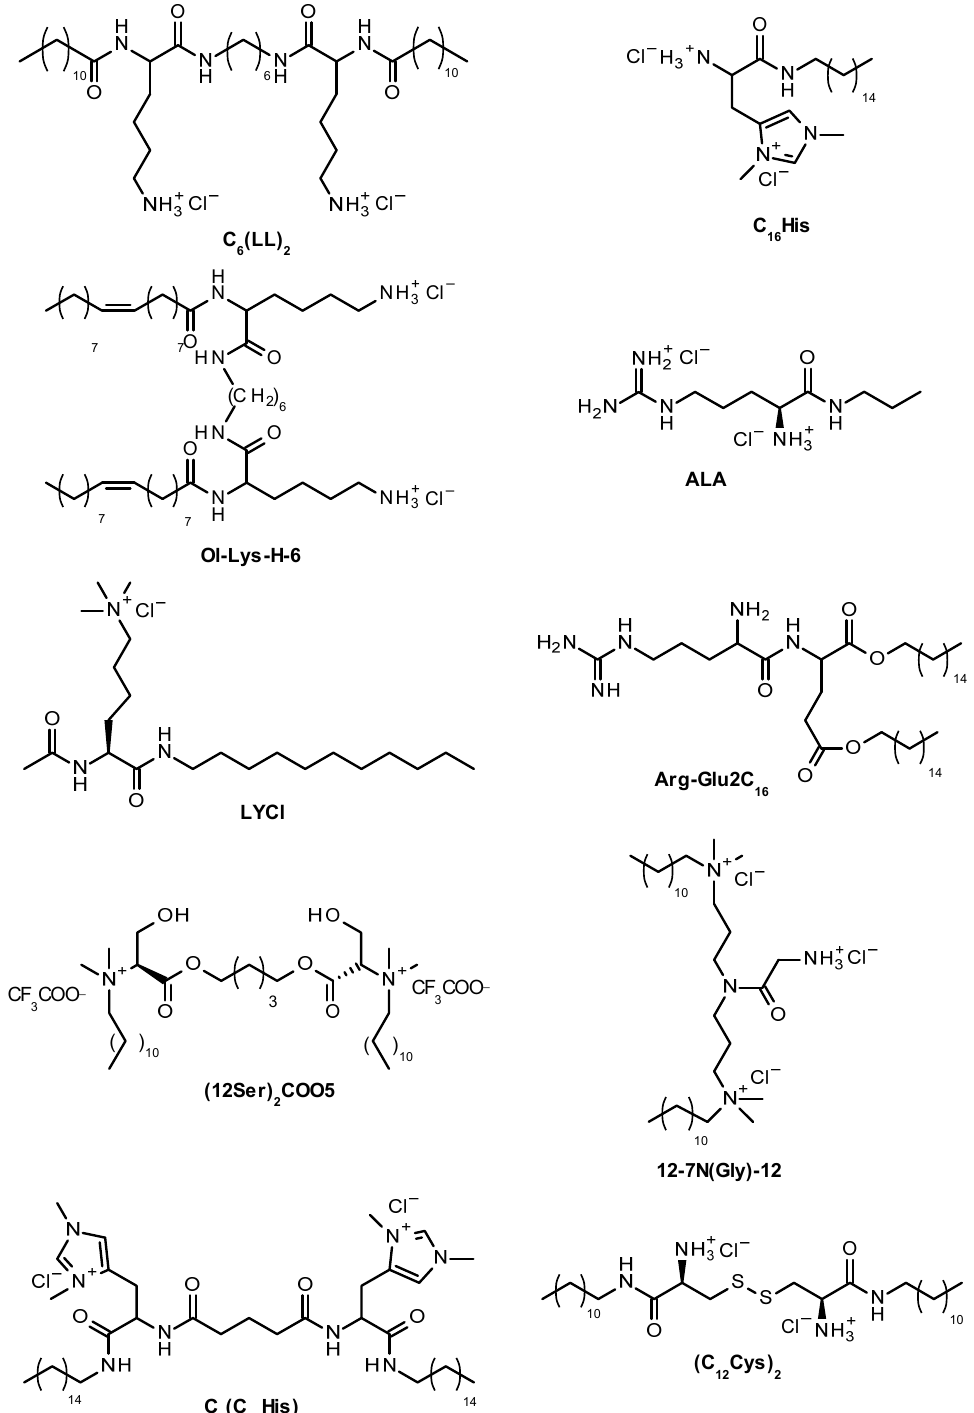
Figure 1. Some lipoaminoacid structures with promising potential as transfection vectors for gene